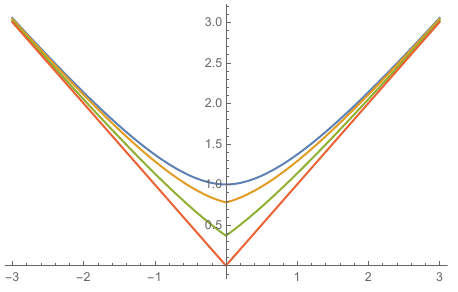
Figure 5 . Quantum corrections turn the singularity into a smooth IR potential ( d = 4 ): the V-shaped bare potential corresponds to k = ∞ and the smooth Wilsonian effective potential to k = 0 . The intermediate running potentials correspond to finite values of k . Note that the latter potentials are not differentiable, and only the deep IR effective potential is